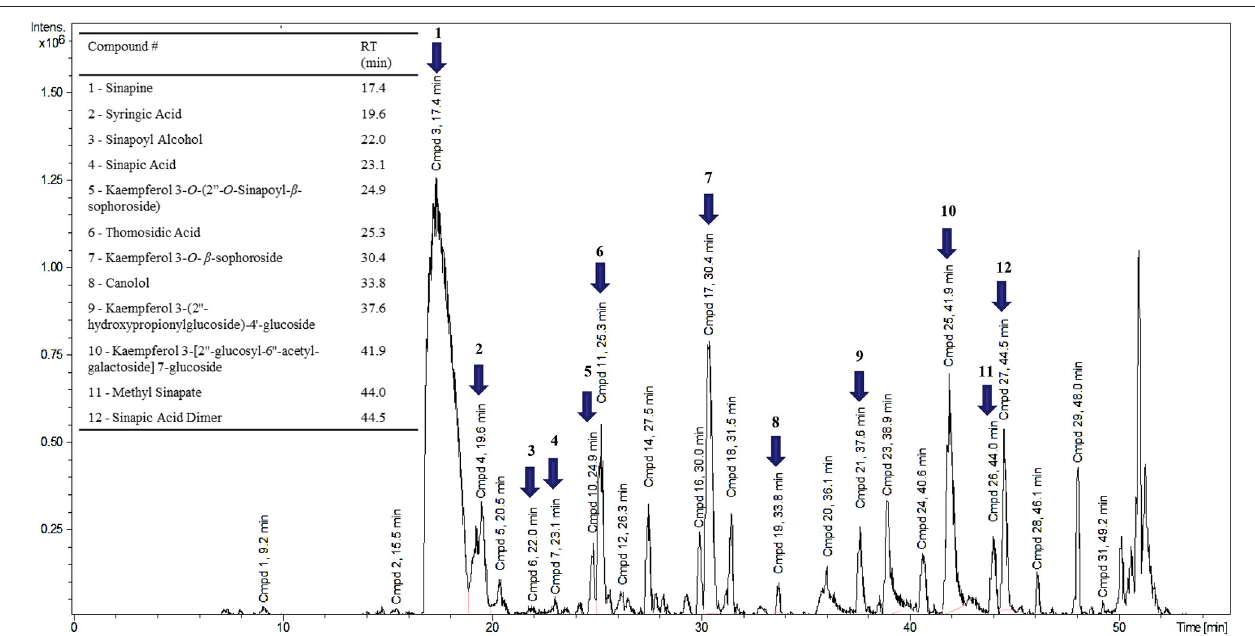
FIGURE 6 | Liquid chromatogram of a representative canola meal extract pre heat treated at 160 ◦ C with tentative identification of phenolic compounds using LC-MS analysis (RT- retention time, min- minutes).